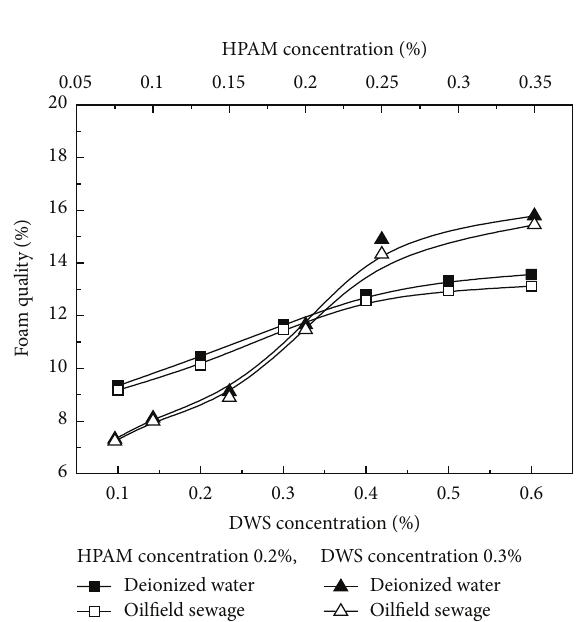
Figure 5: Foam quality of DWS in HPAM system.